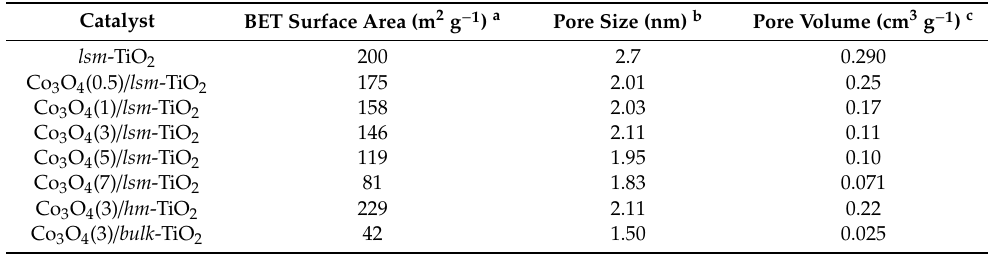
Table 1. Textural properties of the lsm -TiO 2 and Co 3 O 4 ( x ) / lsm -TiO 2 catalyst derived from nitrogen adsorption and desorption